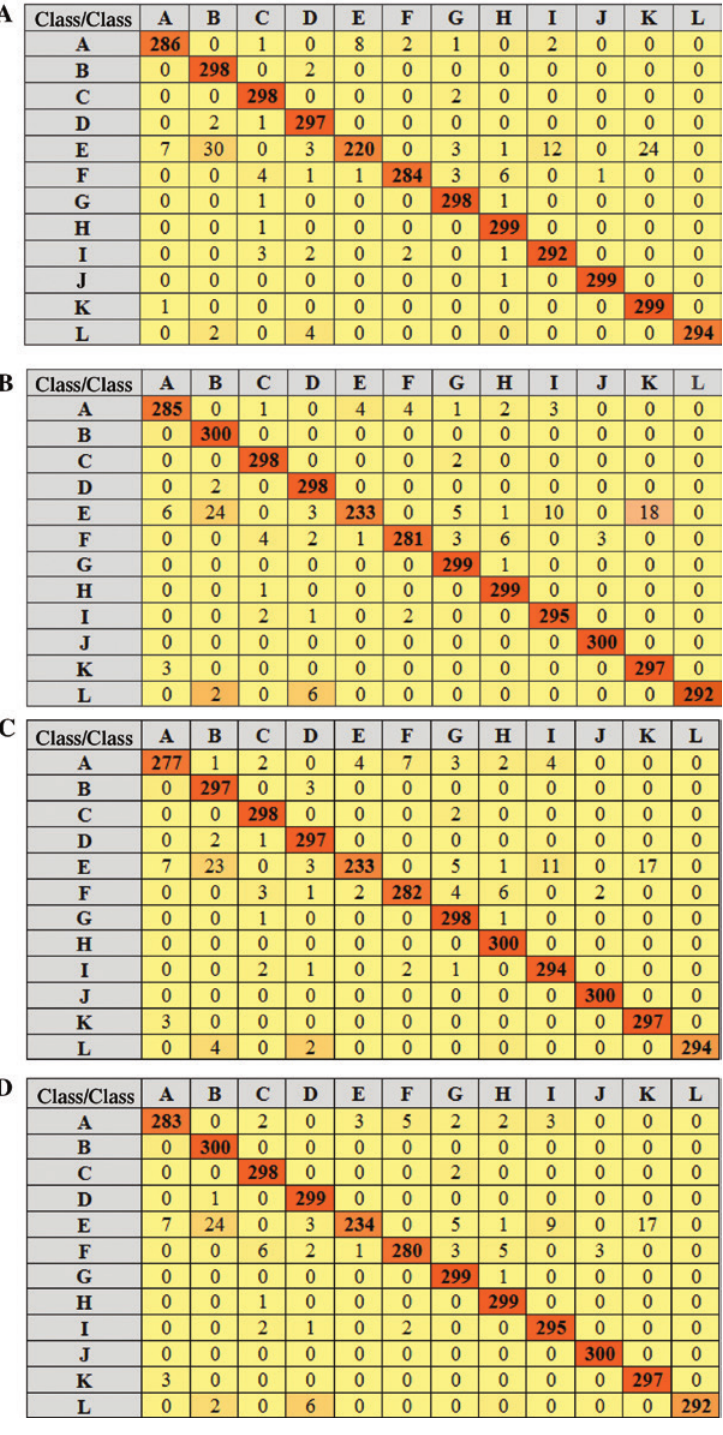
Figure 9: Class-Wise Classification Statistics Obtained by: (A) First Procedure, (B) Second Procedure, (C) Third Procedure, and (D) Fourth